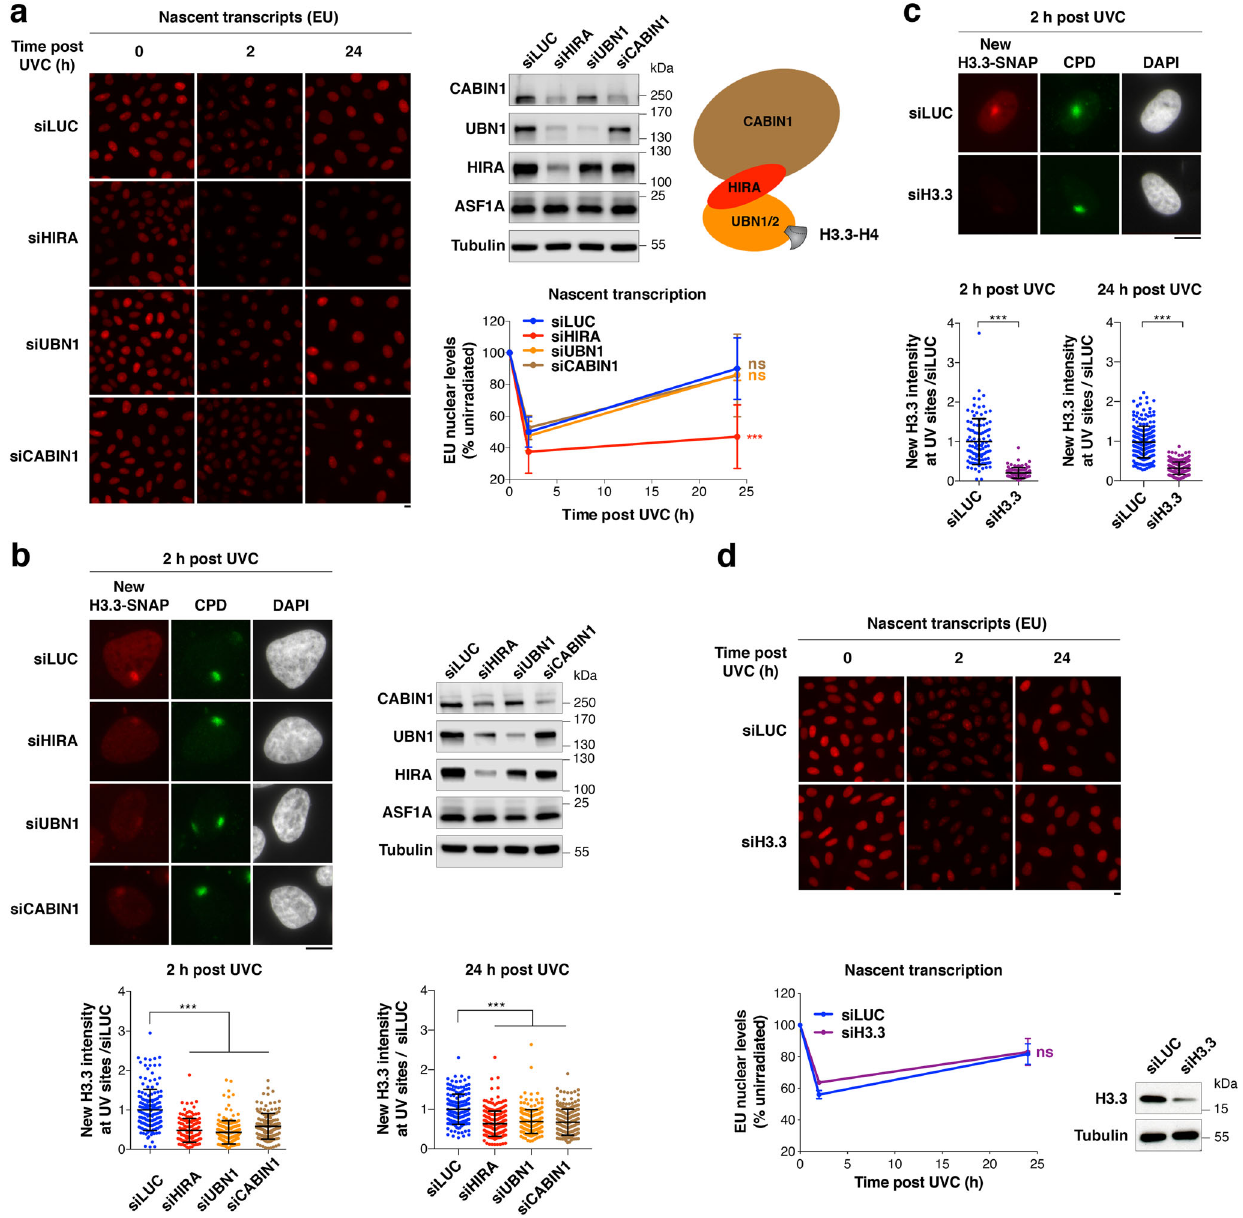
Fig. 1 HIRA-mediated transcription restart post UVC damage is independent of new H3.3 deposition. a Fluorescence images showing nascent transcripts labelled with ethynyl-uridine (EU) in unirradiated (0 h) or UVC-irradiated (2 h, 24 h) HeLa cells treated with the indicated siRNAs (siLUC, control). Knock-down ef fi ciencies are controlled by western blot at the time of UV irradiation (Tubulin, loading control). The scheme on the right represents the HIRA complex chaperoning H3.3-H4. The graph shows quanti fi cation of nascent transcript levels post UVC relative to unirradiated cells using the same colour code as the scheme for HIRA complex subunits. b , c New H3.3 accumulation at UVC damage sites (marked by CPD immunostaining) analysed 2 h and 24 h post local UVC irradiation in U2OS H3.3-SNAP cells treated with the indicated siRNAs (siLUC, control). The scatter plots show new H3.3 levels at UV sites (mean ± s.d. from at least 86 cells scored in three independent experiments). siRNA ef fi ciencies are controlled by western blot for HIRA complex subunits (Tubulin, loading control), and by new H3.3-SNAP labelling for H3.3. d Nascent transcript levels analysed by ethynyl-uridine incorporation (EU) as in ( a ). The line graphs show mean values ± s.d. from four ( a ) and three ( d ) independent experiments scoring at least 81 cells per experiment. Statistical signi fi cance is calculated by two-way ( a , d ) and one-way ANOVA ( b ) with Bonferroni posttest, and via two-sided Student ’ s t -test with Welch ’ s correction ( c ). ***: p < 0.001; ns: p > 0.05. Scale bars, 10 μ m. Source data are provided as a Source Data fi